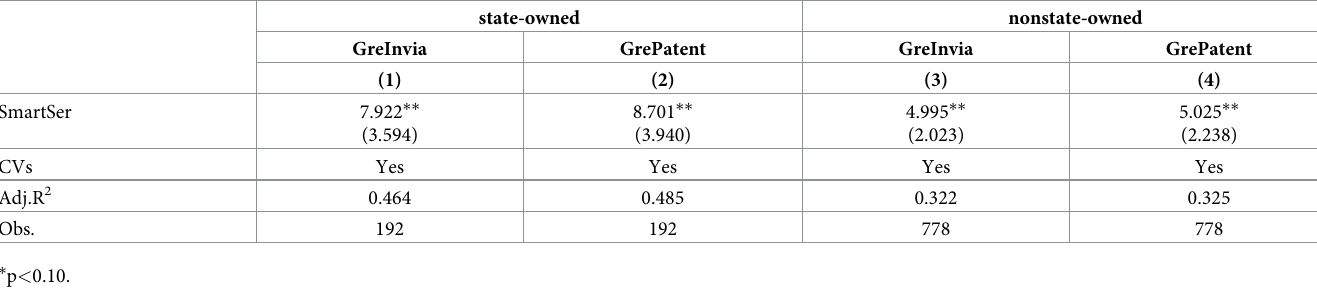
Table 11. Results of property right attribute